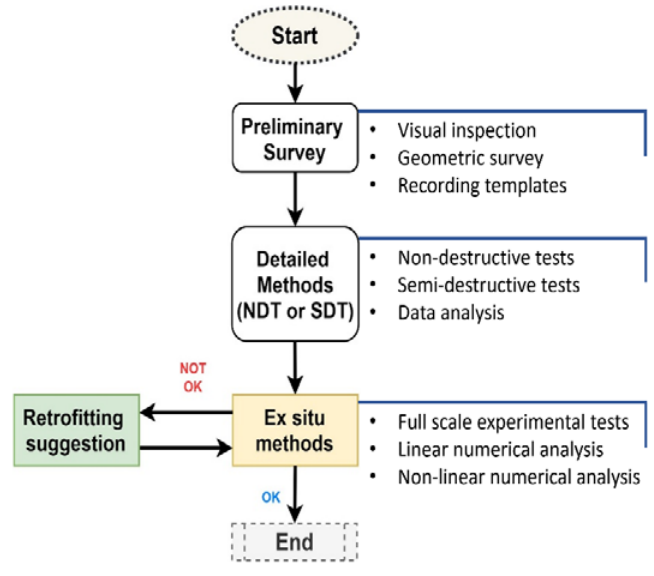
Figure 11. HYPERION methodology for vulnerability assessment and conservation of heritage timber buildings.